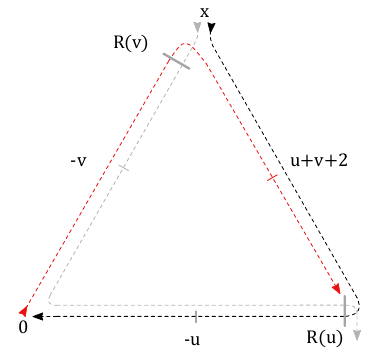
Figure 7 . Left: diagrammatic form of the l.h.s. (2.32) of the star-triangle duality as a star of propagators. Right: diagrammatic form of the r.h.s. (2.33) of the star-triangle duality as a triangle of propagators. The spinor indices are mixed by the SU(2) fused R -matrices that are contracted with the matrices σ , σ appearing in the definition (2.14), and their position is denoted by grey solid lines. The black dot in the star is the integrated point y . The letter adjacent to each segment is the scaling dimension of the